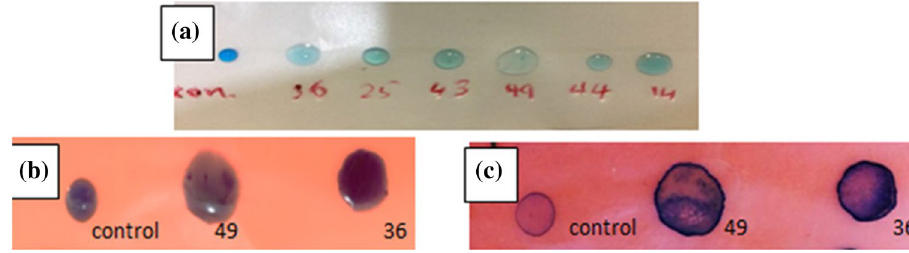
Fig. 6 Drop collapse test a different strains comparing with control, b 49 and 36 isolates, c after drying